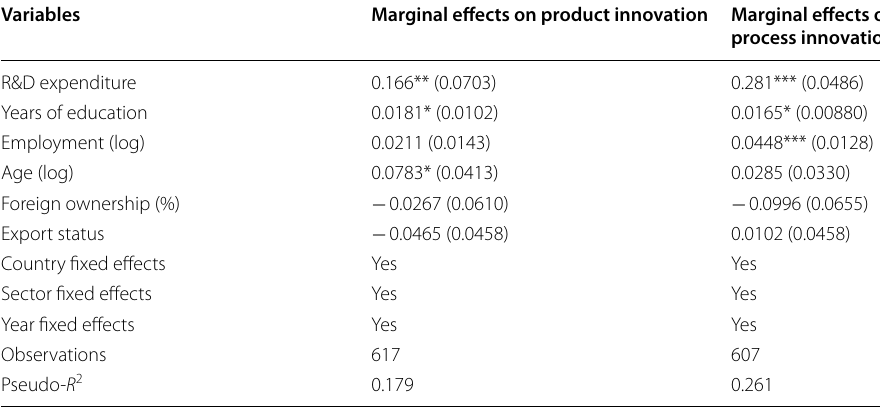
Table 4 Product innovation and process innovation